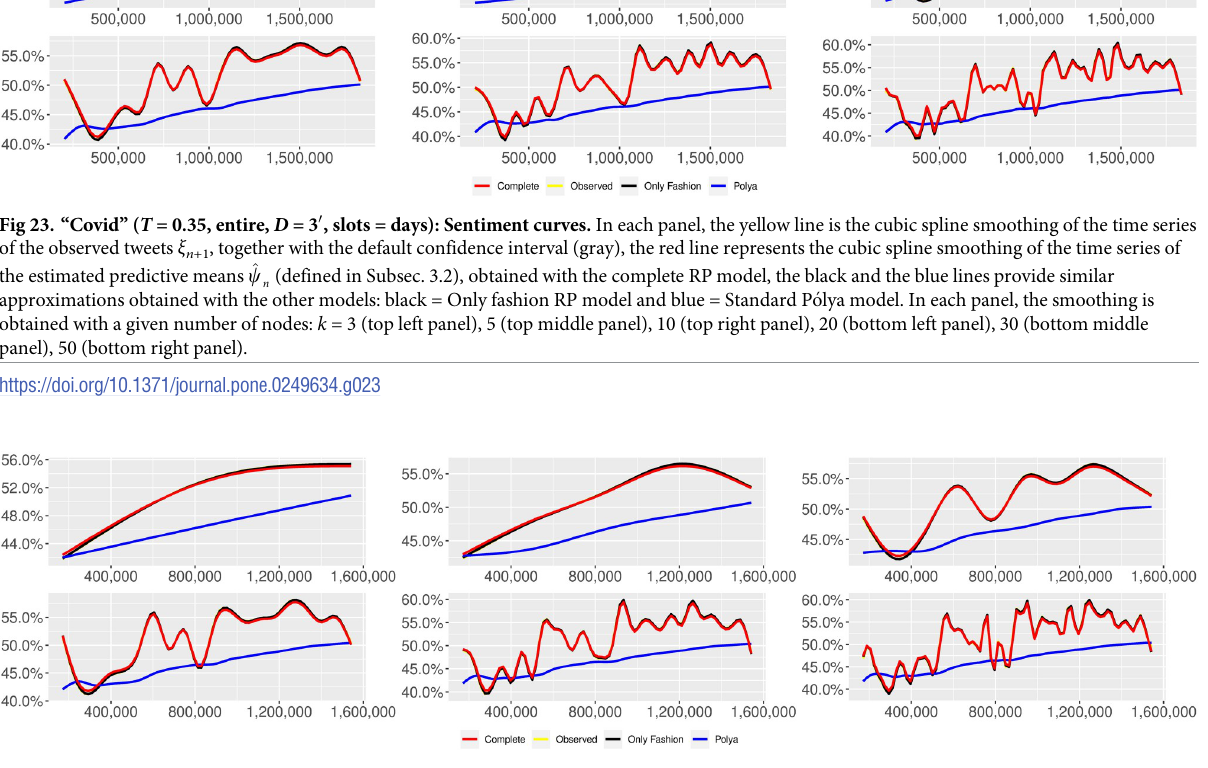
Fig 24. “Covid” ( T = 0.5, entire, D = 3 0 , slots = days): Sentiment curves. In each panel, the yellow line is the cubic spline smoothing of the time series of the observed tweets ξ , together with the default confidence interval (gray), the red line represents the cubic spline smoothing of the time series of n +1 the estimated predictive means ^ c (defined in Subsec. 3.2), obtained with the complete RP model, the black and the blue lines provide similar n approximations obtained with the other models: black = Only fashion RP model and blue = Standard Po´lya model. In each panel, the smoothing is obtained with a given number of nodes: k = 3 (top left panel), 5 (top middle panel), 10 (top right panel), 20 (bottom left panel), 30 (bottom middle panel), 50 (bottom right panel).